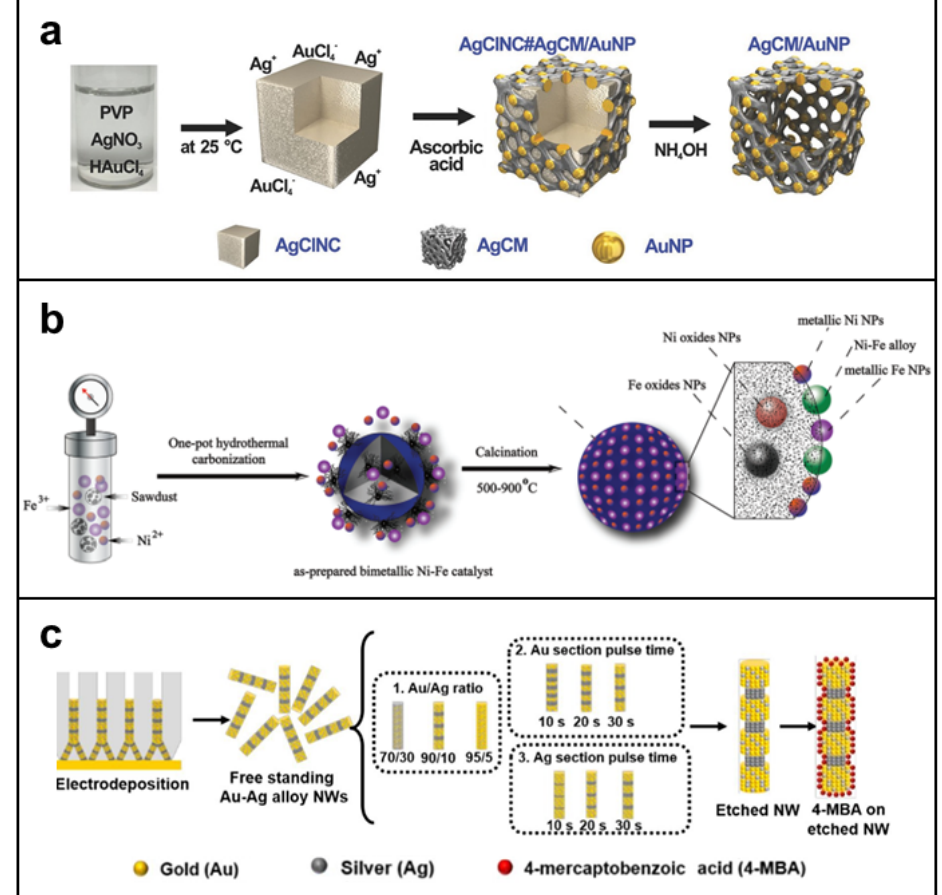
Figure 1. The synthesis methods of BMNs. ( a ) Co-reduction and template-assisted synthesis used for AgCM/AuNPs. Adapted with permission from Ref. [27]. Copyright © 2017 John Wiley & Sons, Inc. ( b ) Schematic diagram of hydrothermal synthesis of NiFe alloy NPs. Reprinted with permission from Ref. [31]. Copyright © Royal Society of Chemistry 2022. ( c ) The principle of electrodeposition for the synthesis of Au–Ag alloy nanowires. Reprinted with permission from Ref. [48]. Copyright © 2019 Elsevier B.V.